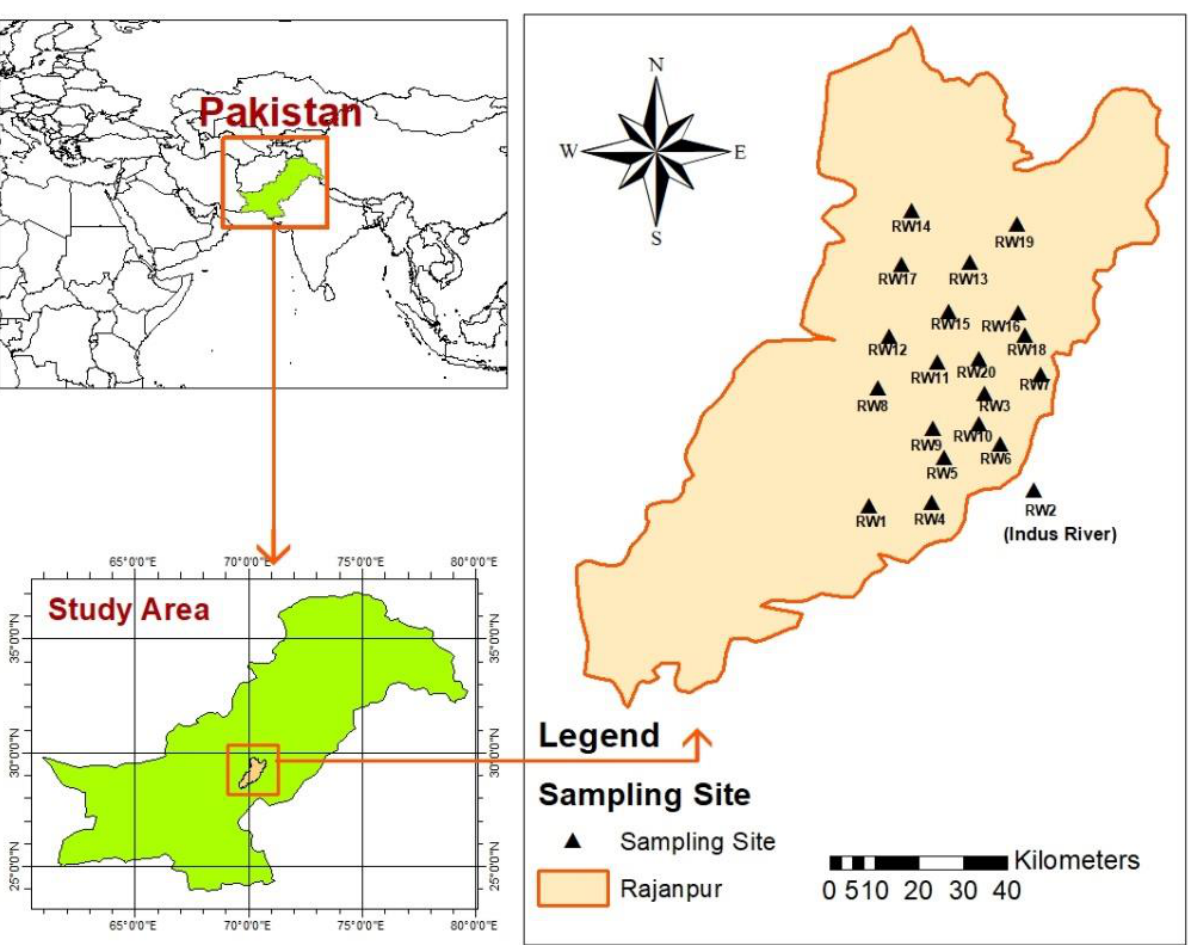
Figure 1. Location map showing sampling sites in the study area .